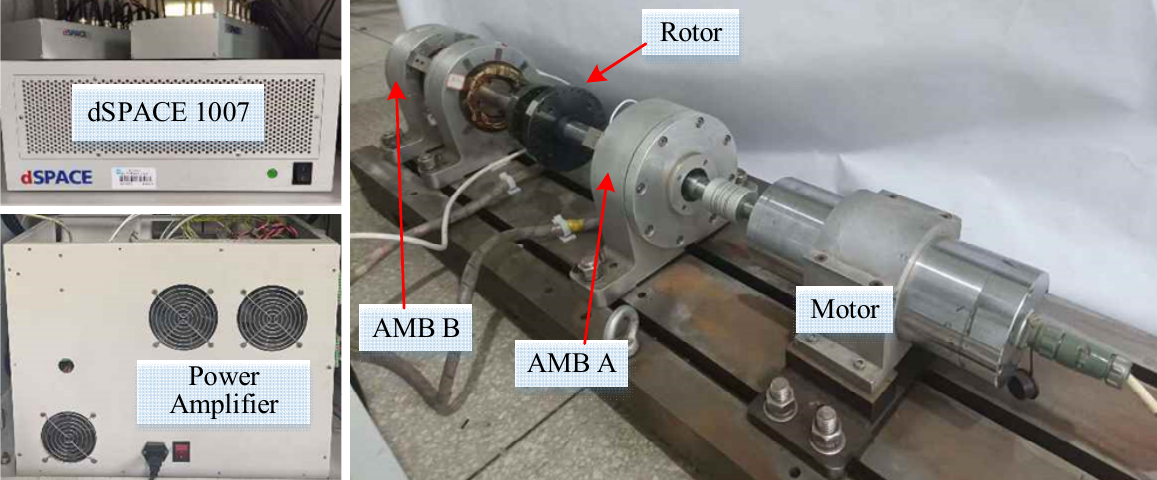
Figure 12. Sensitivity function of the closed-loop system. Figure 12. S ensitivity function of the closed-loop system.